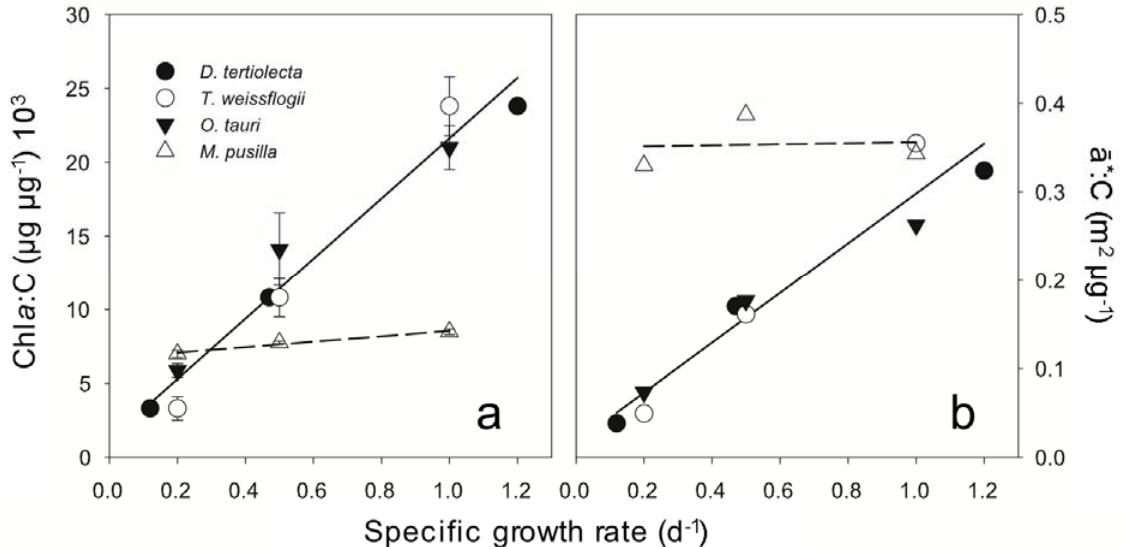
Figure 1. (a) The relationship between Chl :C and nitrogen limited growth rate in a M. pusilla (  and dashed line) contrasts with O. tauri (  ), D. tertiolecta (  ), and T. weissflogii (  ) given by the linear regression for all three species (solid line). (b) The relationships between carbon-normalized absorption and growth rate for all four species studied. Solid line is the linear regression for data for D. tertiolecta (  ), and T. weissflogii (  ) that were previously reported